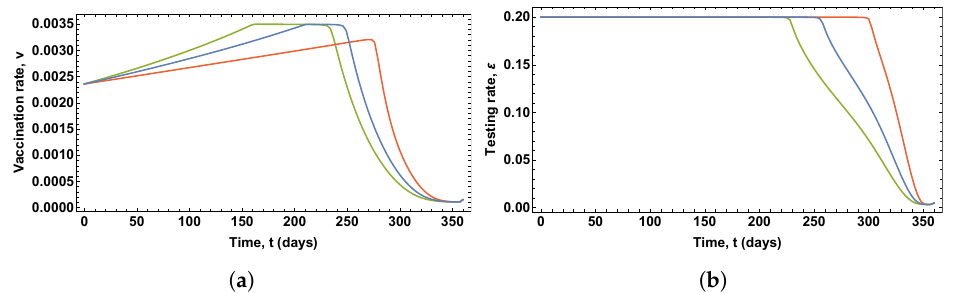
Figure 6. Optimal policies obtained assuming vaccine efficacy levels φ = 0.50 (red), φ = 0.75 (blue), and φ = 0.95 (green), with C 1 = 1, C 2 = 0.1, and C 3 = 0.0001: ( a ) Optimal vaccination rates. ( b ) Optimal testing rates.